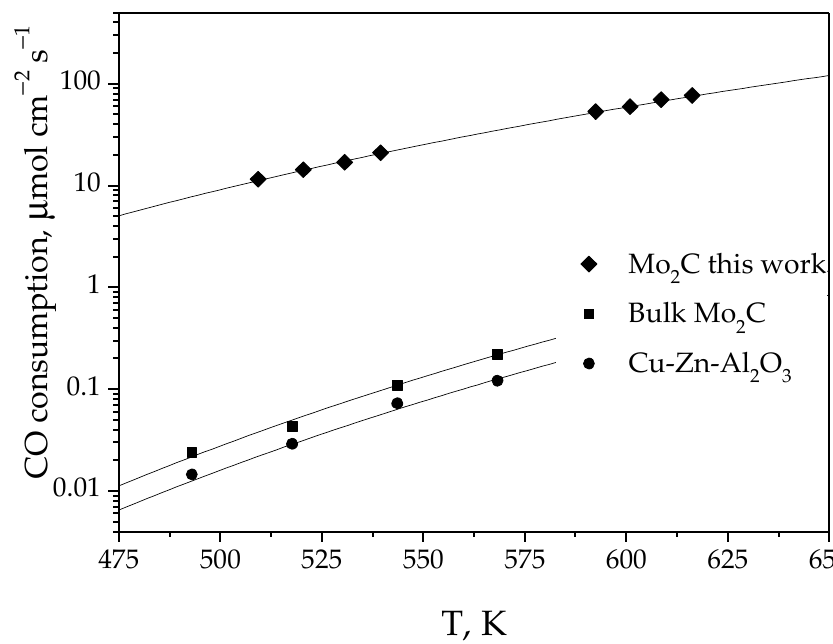
Figure 3. Temperature dependence of the steam reforming reaction rate over different catalysts. Reaction conditions: p CO = 300 Pa, p H Reaction conditions: 𝑝 helium. The gas flow rate is 50 cm 3 min − 1 lium. The gas flow rate is 50 cm 3 min − 1 (STP).